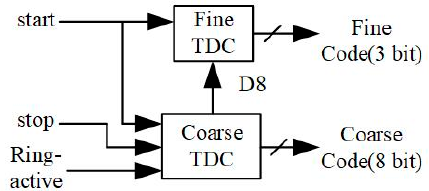
Figure 3. Diagram of